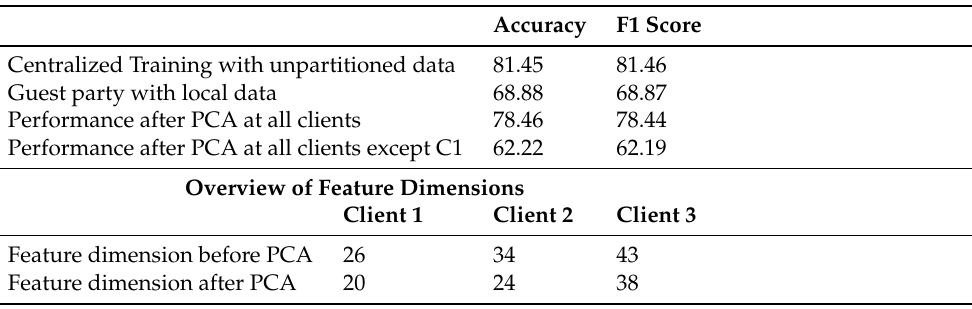
Table 2. Experimental Results on Adult Income Dataset.